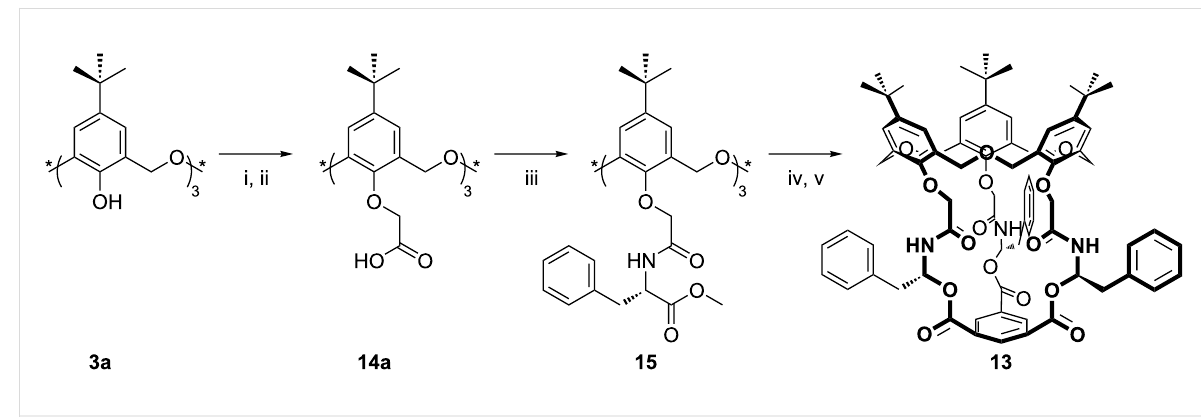
Scheme 9: Forming chiral receptor 13 : (i) Ethyl bromoacetate, NaH, THF; (ii) NaOH, H 2 O/1,4-dioxane; (iii) S -PheOMe ∙ HCl, DCC, HOBt, NEt 3 , CH 2 Cl 2 ; (iv) LiBH 4 , THF; (v) 1,3,5-benzenetricarbonyl chloride, pyridine, THF [31].